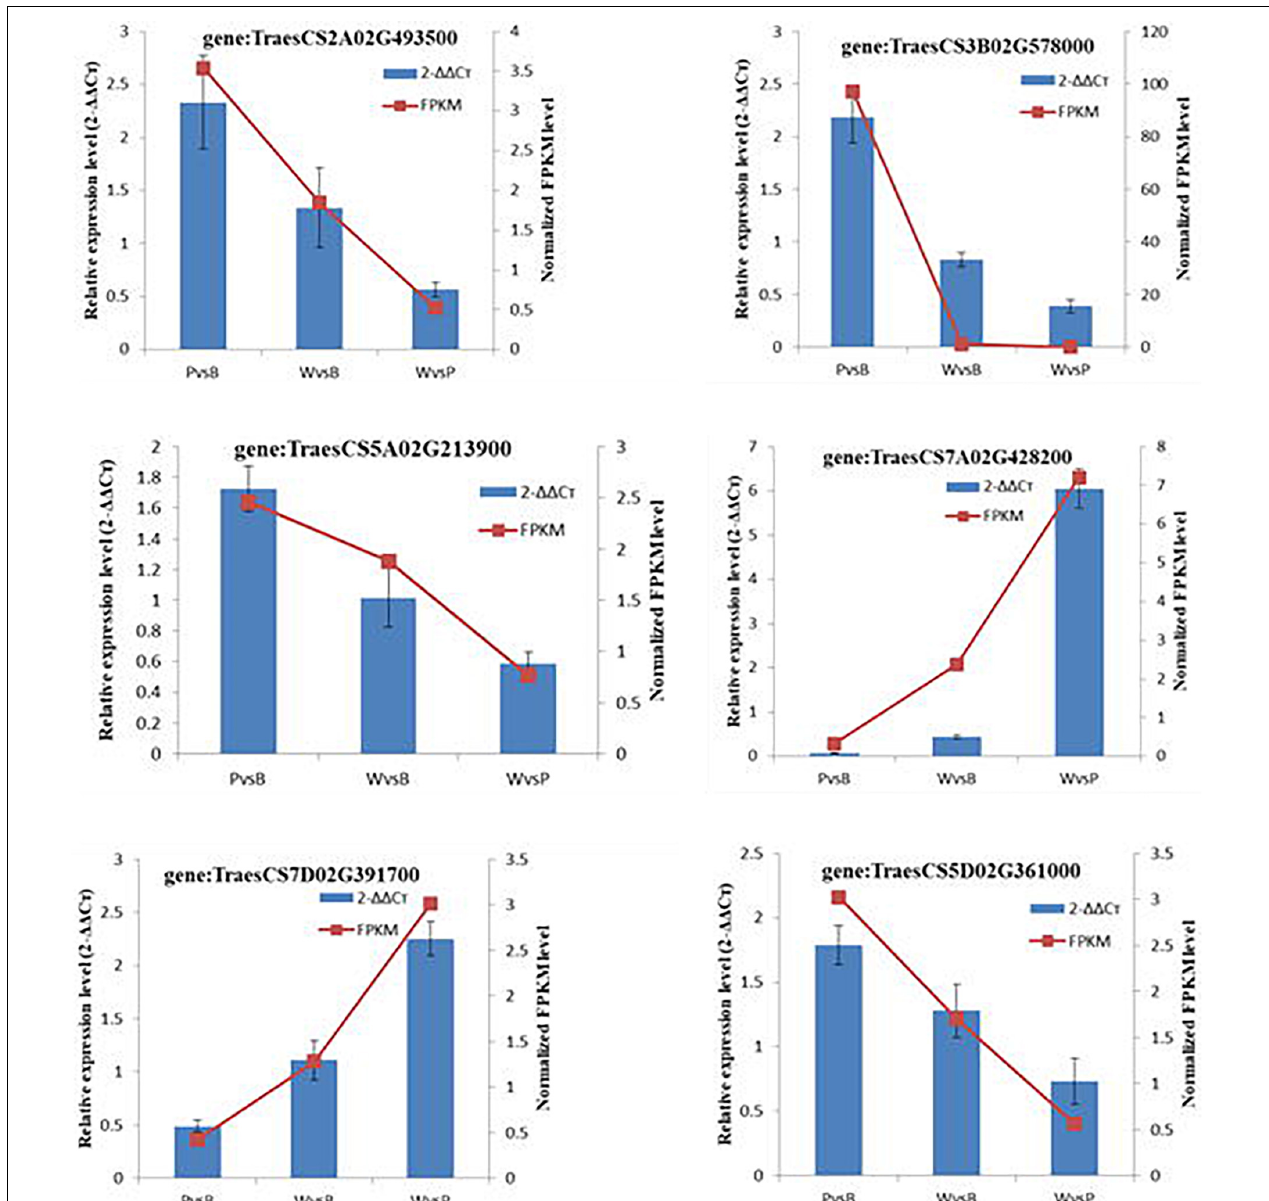
FIGURE 6 | qRT-PCR validation of transcription levels of randomly selected DEGs.